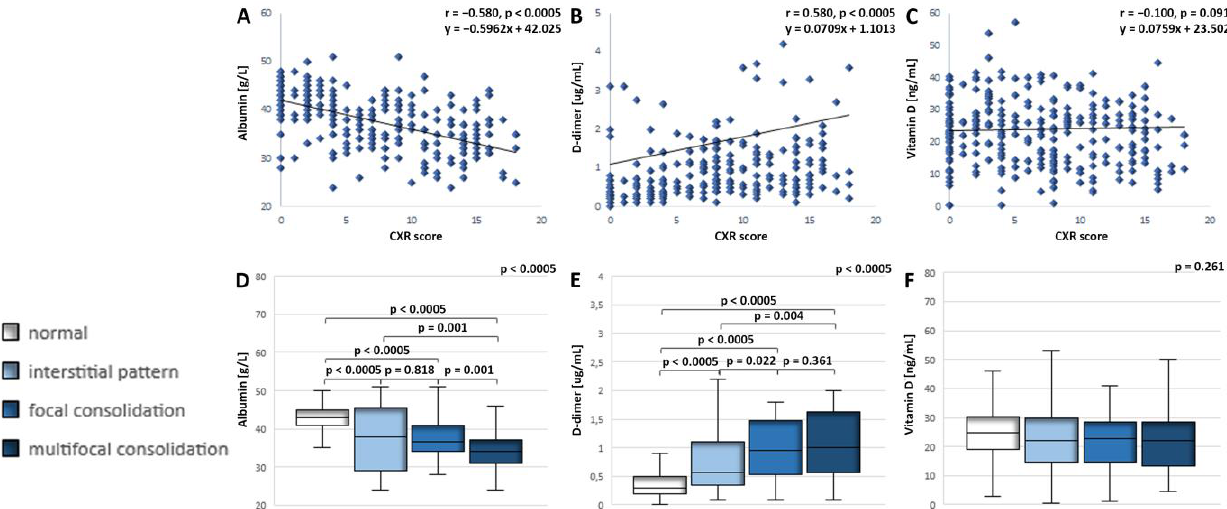
Figure 3. Serum albumin and D-dimer levels are associated with radiographic lung changes in patients with COVID-19. The serum values of the examined biochemical parameters were obtained from blood samples immediately after admission to the hospital for treatment. Chest X-ray images were divided by two lines into six zones. Each zone was scored based on the changes in the lung tissue. Then, the CXR score was calculated as the sum of the individual scores of each zone (range: 0 to 18). According to the CXR score, the findings were categorized as normal, diffuse marked interstitial patterns, focal consolidation of lung tissue, or multifocal consolidation (n = 288). ( A ) Correlations of serum albumin; ( B ) D-dimer; and ( C ) vitamin D values with the lung changes expressed by the CXR score. Based on the CXR score, the lung findings were classified as normal, accentuated interstitium, and focal or multiple consolidation. ( D ) Differences in the values of serum albumin (Mdn = 43.0 g/L (41.0, 45.0), n = 96 vs. Mdn = 38 g/L (34.0, 40.0), n = 44 vs. Mdn = 36.5 g/L (34.0, 41.0), n = 56 vs. Mdn = 34.0 g/L (31.0, 37.0), n = 91; p < 0.0005); ( E ) D-dimer (Mdn = 0.3 ug/mL (0.2, 0.5), n = 96 vs. Mdn = 0.6 ug/mL (0.3, 1.1), n = 44 vs. Mdn = 1.1 ug/mL (0.5, 1.5), n = 56 vs. Mdn = 1.0 ug/mL (0.6, 1.7), n = 91; p < 0.0005); and ( F ) vitamin D (Mdn = 24.8 ng/mL (19.2, 30.2), n = 96 vs. Mdn = 22.2